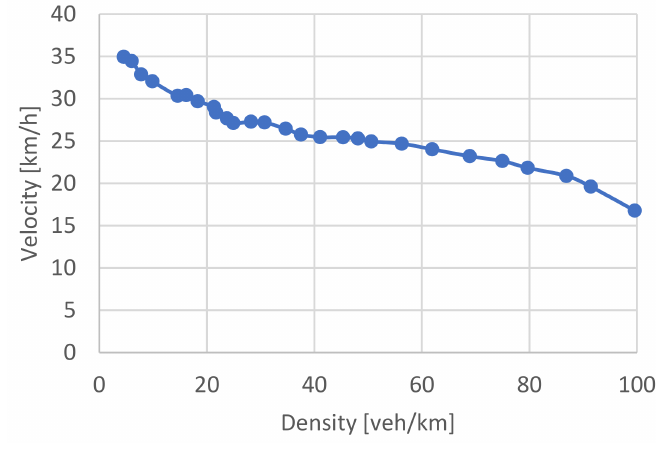
Figure 13. Traffic density–speed relation, source: own.